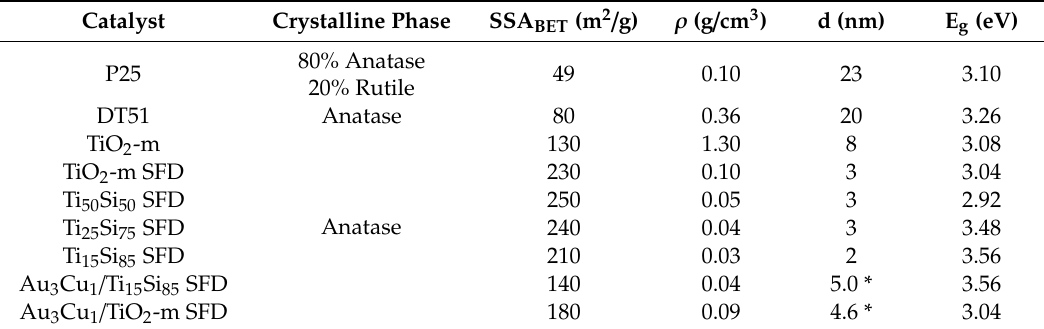
Table 1. Prepared samples and main characterization data obtained from XRD, DRS, and